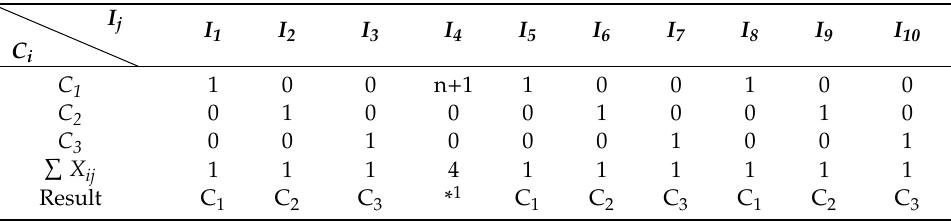
Table 3. Demonstration of COI.